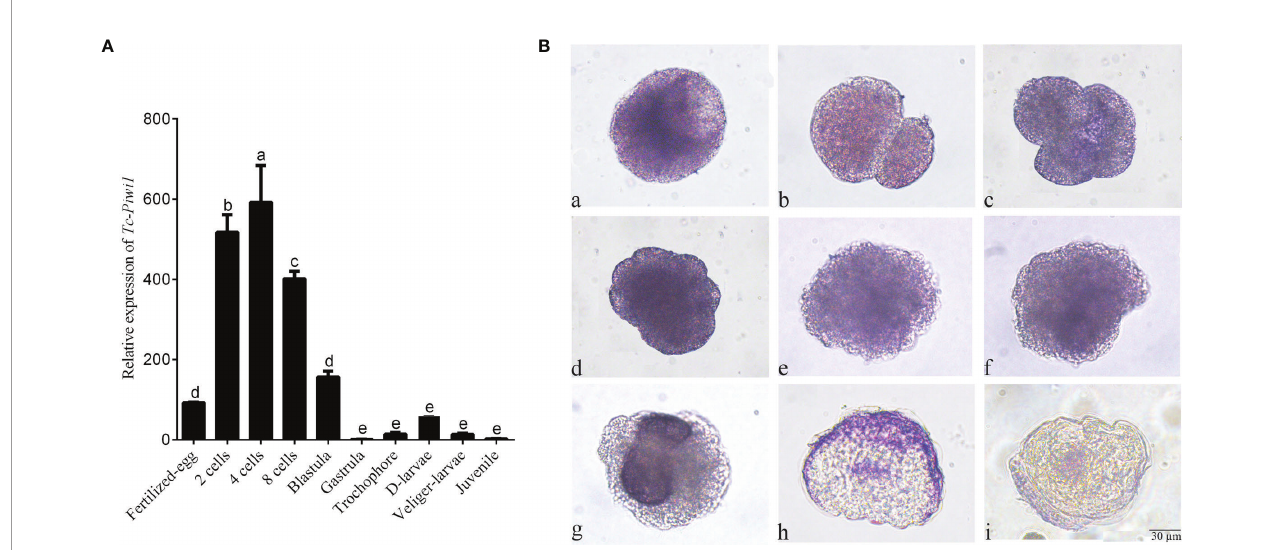
FIGURE 5 | Expression of Tc-Piwi1 gene in fertilized oocytes and various embryonic stages of T. crocea . (A) Quantitative real-time PCR results for Tc-Piwi1 , and RPL5 was used as a reference gene. Data are represented as the mean ± SD (N = 3), bars not sharing with the same letter are signi fi cantly differed at p < 0.05. (B) Location of Tc-Piwi1 in the fertilized egg and various developmental stages of embryos by WISH. (a) Fertilized eggs; (b) 2 cells; (c) 4 cells; (d) 8 cells; (e) Blastula; (f) Gastrula; (g) trochophore larvae; (h) D-shaped larvae; (i) Veliger larvae. Scale bar = 30